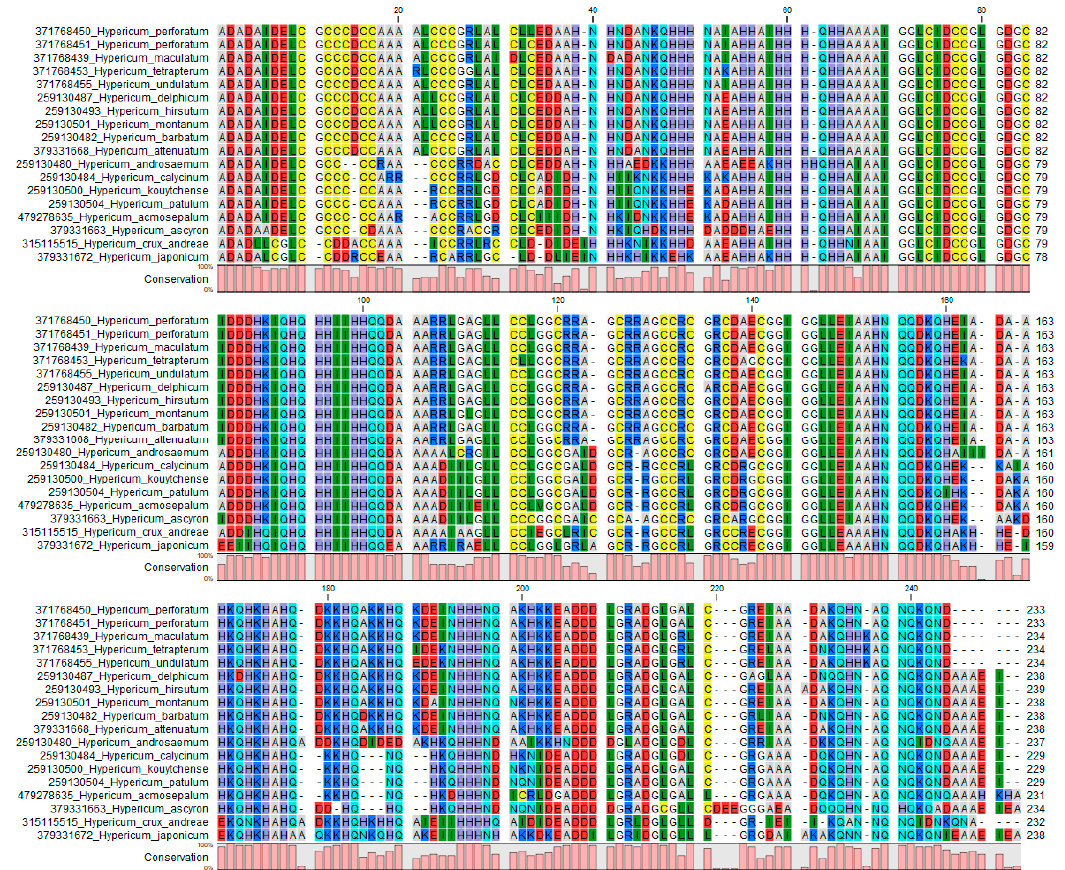
Figure 2. Alignment of panel species ITS2 sequences with RNA secondary structure represented by a single letter (pseudo amino acid) code [47].